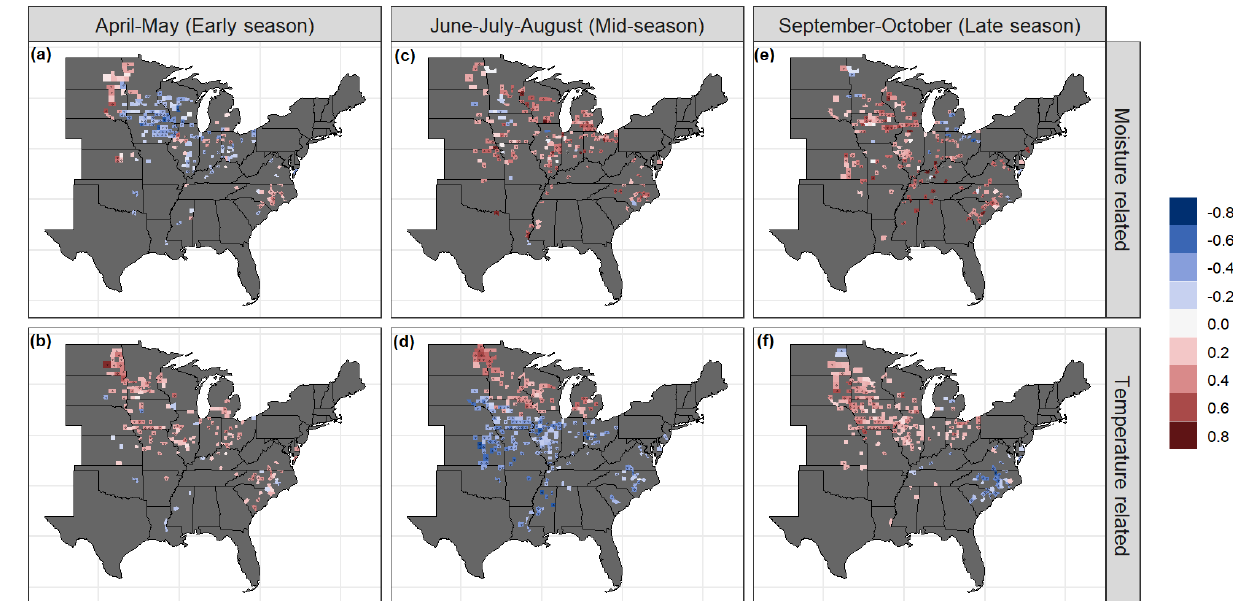
Figure 4. Region- and season-specific estimated sensitivity coefficients for soybean yield and selected predictors. The stippling indicates statistical significance from a t test at the 95% confidence level. Values of coefficients are interpreted as the change in soybean yield standard deviation from a 1-standard-deviation change in the considered independent variable. Temperature-related variables can refer to either T min or T max depending on the selected variable in a given county. Similarly, moisture-related variables can refer to either SM root or Num_pr20. Finally, for each seasonal bracket (i.e. early, mid or late), the selected time resolution for each variable can either be a seasonal aggregate or the value for a specific month within that bracket. We refer the reader to Figs. A1 and A2 in the Appendix for a more detailed account of the selected variables per